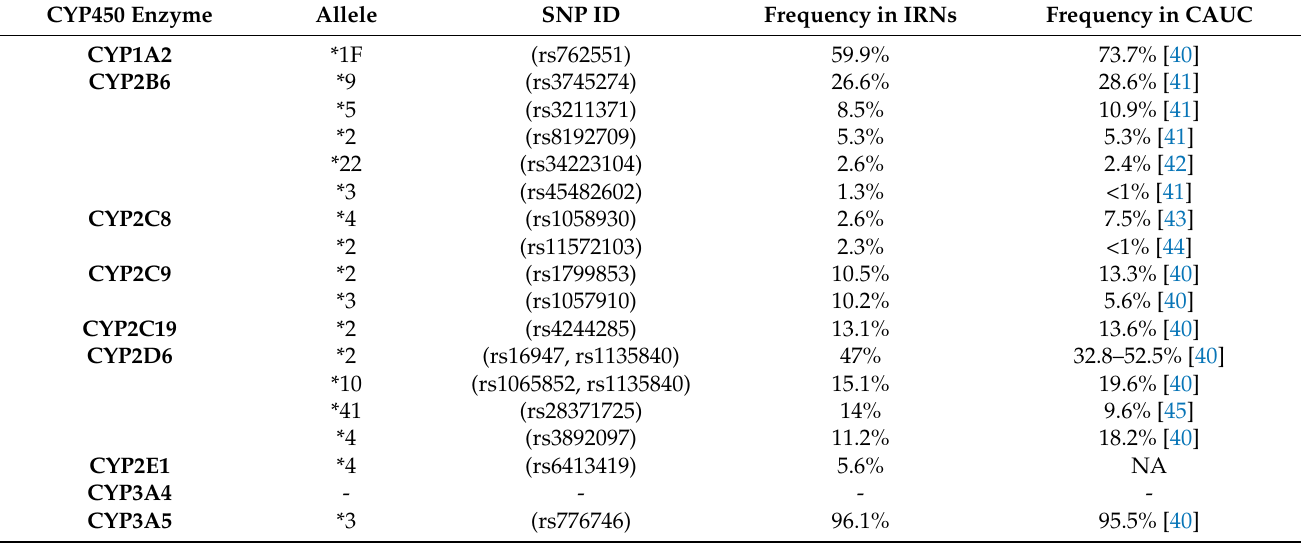
Table 3. Prevalence of frequent alleles related to 9 CYP450 genes in Iranian population compared to Caucasian race. CYP450